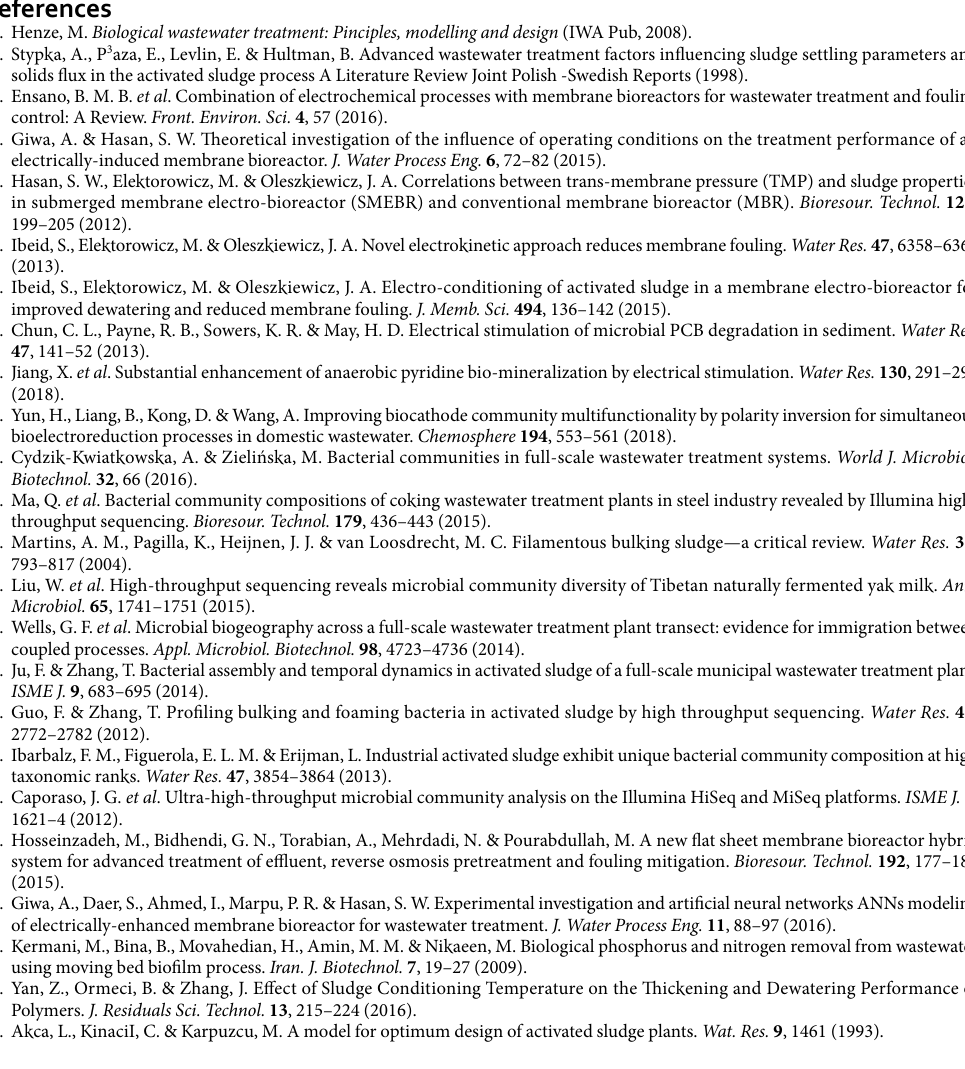
Operational parameters. (Table 4) showing 6 control bioreactor samples (C) and 6 electro-bioreactor samples (E) operated at current density of 3 Am − 2 (i.e. E3) and 7 Am − 2 (i.e. E7) serially passaged for 15 days.